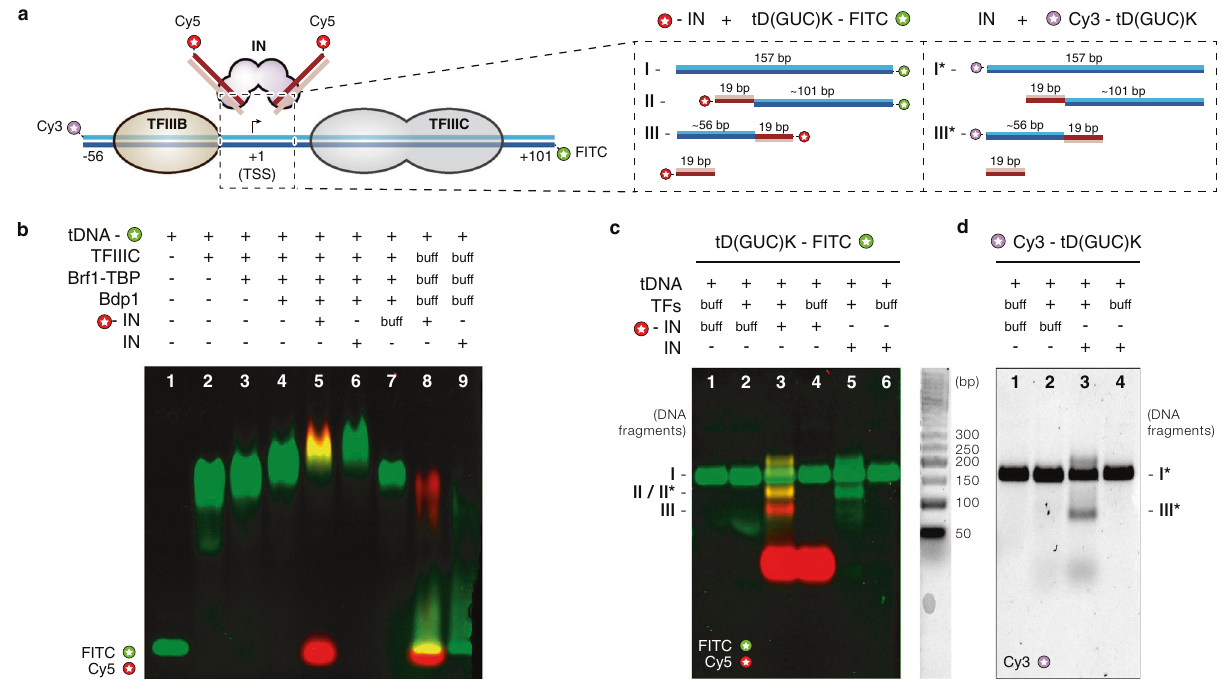
Fig. 1 Assembly and activity of Ty3 retrotransposon machinery. a Schematic representation of components used during binding and activity assays with reconstituted Ty3 retrotransposon machinery. tD(GUC)K template and non-template DNA strands are depicted as dark and light blue lines, respectively. DNA is numbered relative to the transcription start site (TSS). Reactive and non-reactive DNA strands of Ty3 LTRs are shown as dark and light red lines, respectively. TFIIIB and TFIIIC transcription factors, and intasome (IN) complex are depicted as globular shapes and coloured in wheat, grey and pink, respectively. Position and detail of the fl uorophores used in the assays are shown as starred circles. The same colour scheme is used for fl uorophores in b , c . Inset, summary and estimated length of the DNA products expected from integration events in the proximity of the TSS. b Analysis of complex assembly. Electrophoretic mobility shift assay (EMSA) shows sequential binding of transcription factors to the tD(GUC)K DNA (lanes 1 – 4), followed by binding of either Cy5-labelled Ty3 intasome (lane 5) or unlabelled intasome (lane 6) or intasome buffer (lane 7). Incubation of Cy5-labelled Ty3 intasome (lane 8) or unlabelled intasome (lane 9) with tD(GUC)K template in the absence of transcription factors does not lead to a recruitment to the DNA. c Integration activity assays of reconstituted Ty3 intasome (IN) into FITC-labelled tD(GUC)K tDNA or d Cy3-labelled tD(GUC)K tDNA, in the presence